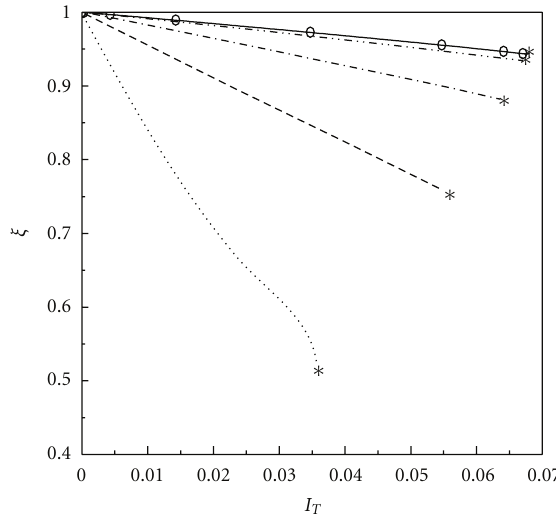
Figure 17: E ffi ciency factor for di ff erent thickness and specific area = 1 . 0 M, κ = 3 . 4 Ω − 1 m − 1 , of the catalyst layer; T = 333 K, c 0 e M D e = 3 . 04 × 10 − 10 m 2 s − 1 , ( (cid:2) ) experiment data, ( ∗ ) dimensionless limiting current density, solid line: l = 10 μ m, a = 1 . 0 × 10 5 m − 1 , dash line: l = 25 μ m, a = 1 . 0 × 10 5 m − 1 , dot line: l = 50 μ m, a = 1 . 0 × 10 5 m − 1 , dash dot line: l = 25 μ m, a = 3 . 75 × 10 4 m − 1 , dash dot dot line: l = 10 μ m, a = 118417 . 0 m − 1 .